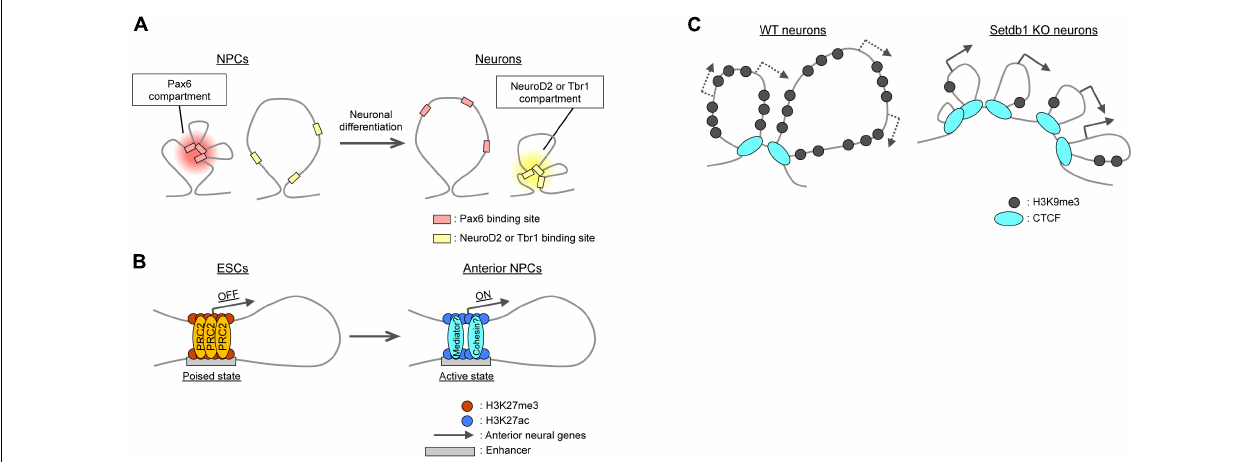
FIGURE 3 | Local changes in 3D genome organization during neural differentiation. (A) Intra-TAD interactions between binding regions for cell type-specific transcription factors such as Pax6, NeuroD2, and Tbr1. (B) Polycomb (PRC2)-mediated interactions between promoters and poised enhancers lead to the activation of anterior neural genes during differentiation. (C) In cortical neurons, H3K9me3 deposition catalyzed by Setdb1 prevents aberrant CTCF binding at Pcdh gene clusters. Knockout (KO) of Setdb1 induces excessive insulation and upregulation of Pcdh gene